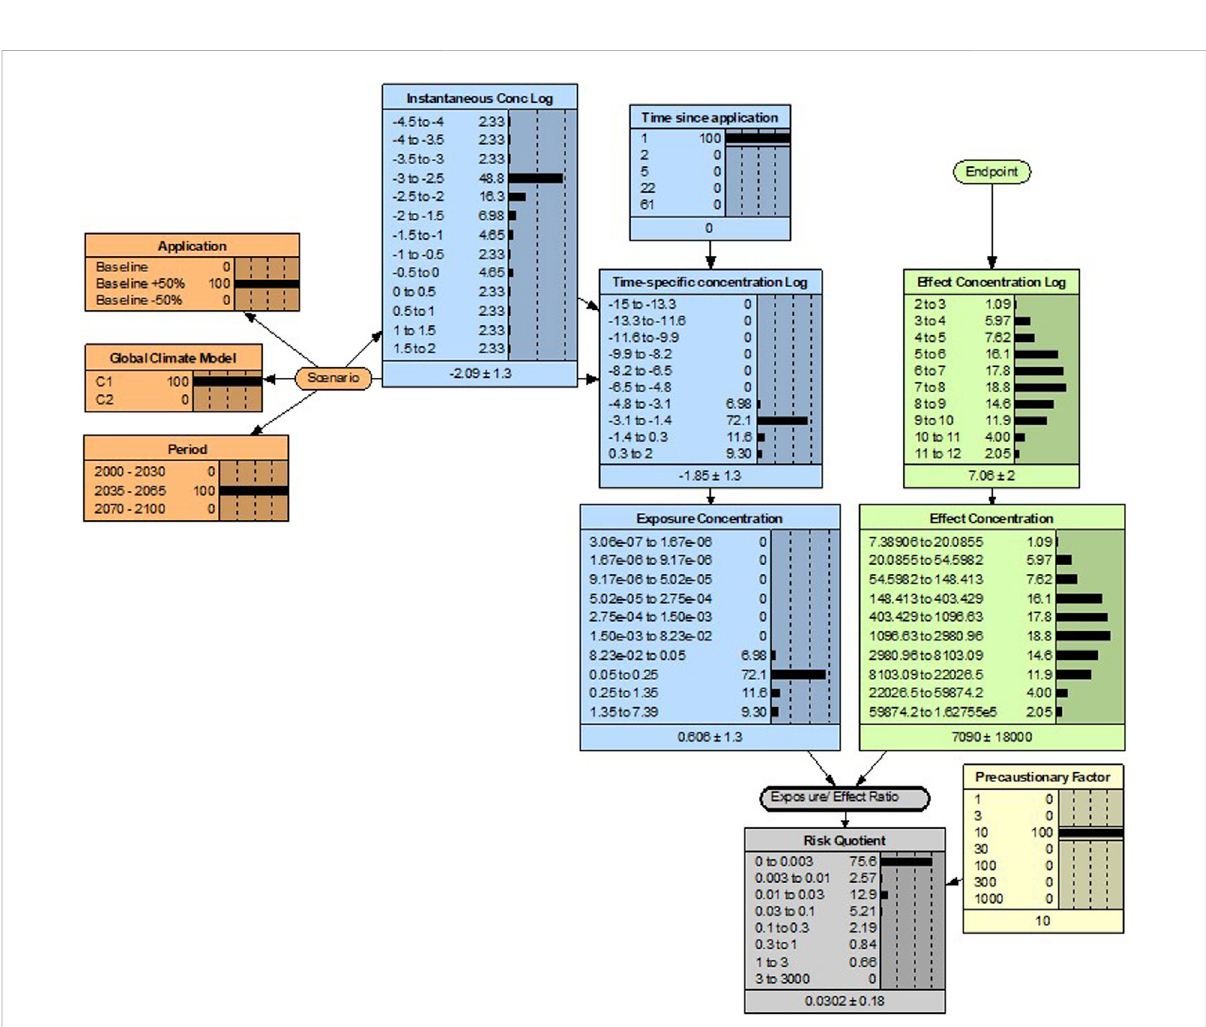
FIGURE 3 Example of the Bayesian network parameterized for fl uroxypyr-meptyl, with a baseline+50% application, global climate model C1, time period of 2035 – 2056, for a time since application of 1 day and a EC50 based effect distribution.